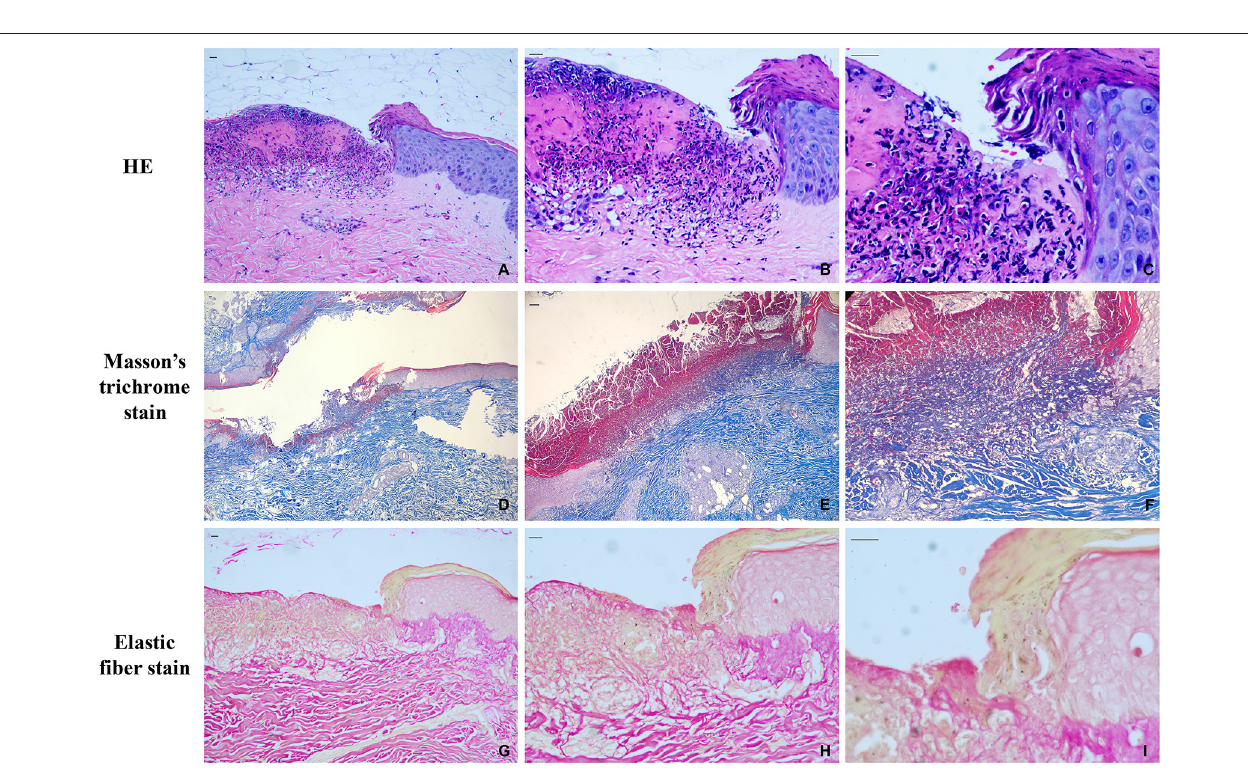
We analyzed the dermoscopy pictures of all 39 patients ( Table 1 ). Dermoscopic images revealed that there are nine features: (1) a yellow-brown homogeneous structureless area in the center of the lesion were found in 38 of the 39 cases, the accrue rate was about 97.43% ( Figure 3A ); (2) dotted and linear